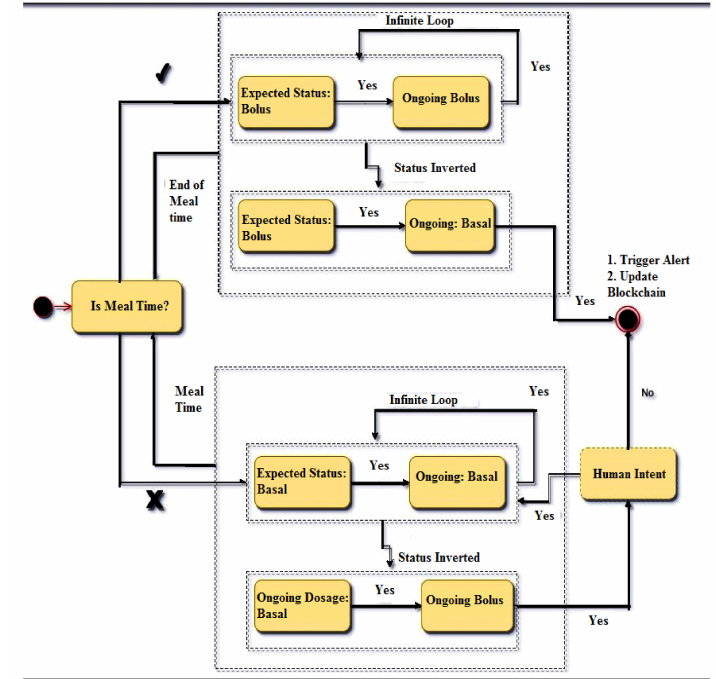
Figure 3. State transition diagram for an IoT/BC insulin pump [16].